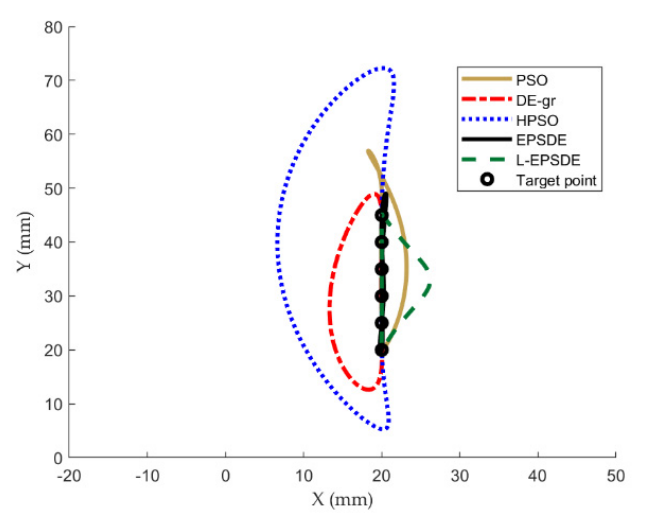
Figure 17. Trajectories of the coupler point of Case 4.